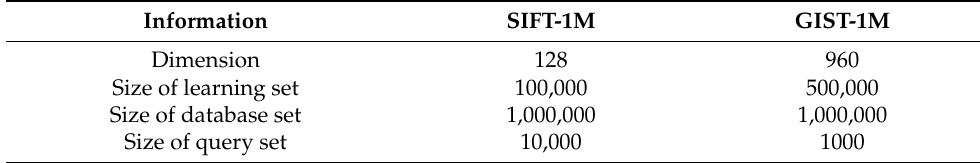
Table 1. Summary of the used datasets.